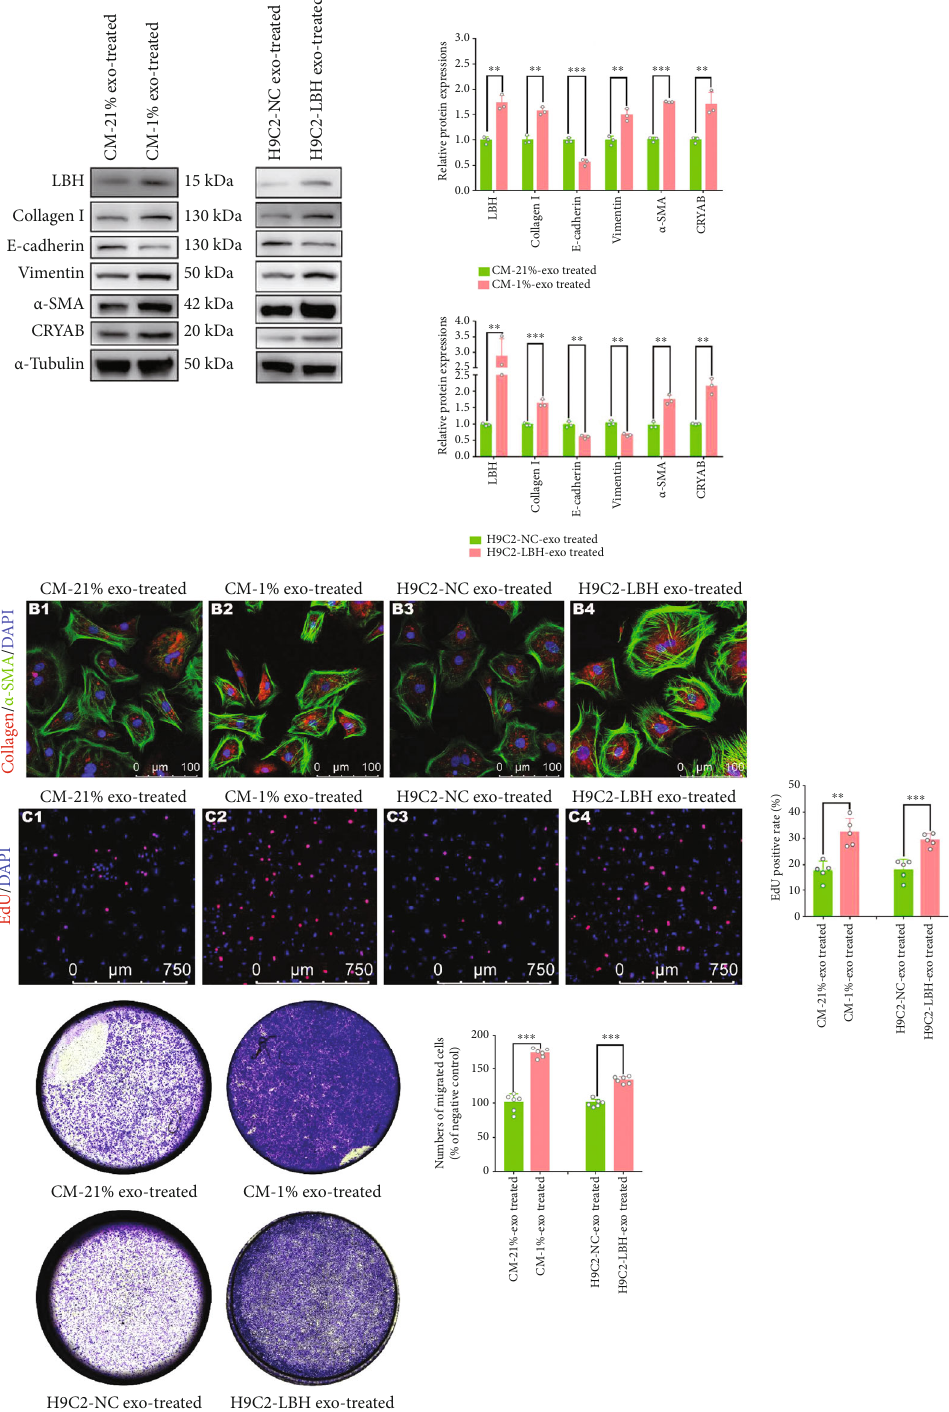
Figure 4: The e ff ects of the internalization of CM LBH+ exosomes on the proliferation, di ff erentiation and migration of CFs. (a) Protein levels of LBH, CRYAB, collagen I, α -SMA, E-cadherin, and vimentin in mouse CFs treated with hypoxic CM-derived exosomes and in rat CFs treated with H9c2-LBH-derived exosomes ( ∗∗ p < 0 : 01 and ∗∗∗ p < 0 : 001 vs. 21%-Exo/Lv5NC-Exo treated). (b) Representative immuno fl uorescence images of α -SMA and collagen I expression in mouse CFs treated with hypoxic CM-derived exosomes and in rat CFs treated with H9c2-LBH-derived exosomes. (c) EdU staining of mouse CFs treated with hypoxic CM-derived exosomes and rat CFs treated with H9c2-LBH-derived exosomes ( ∗∗ p < 0 : 01 and ∗∗∗ p < 0 : 001 vs. 21%-Exo/Lv5NC-Exo treated). (d) Representative images of the Transwell assay of mouse CFs treated with hypoxic CM-derived exosomes and rat CFs treated with H9c2-LBH-derived exosomes and the corresponding statistical analysis ( ∗∗∗ p < 0 : 001 vs. 21%-Exo/Lv5NC-Exo